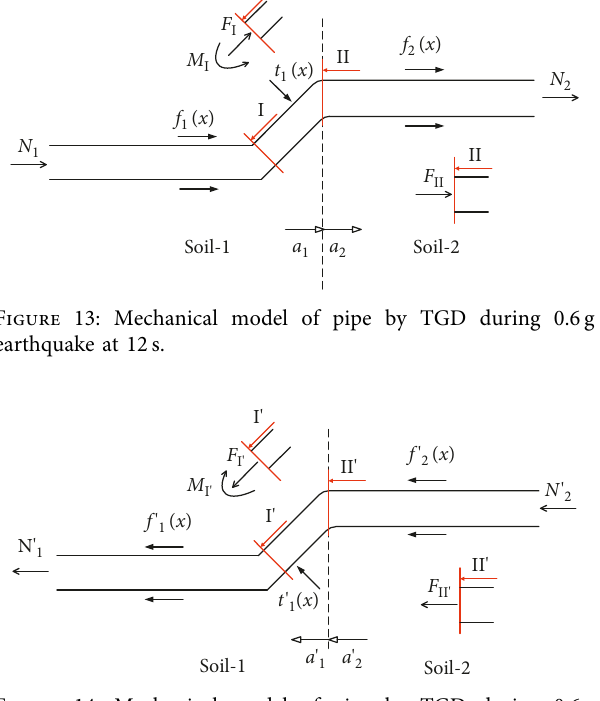
Figure 14: Mechanical model of pipe by TGD during 0.6g earthquake at 18s.